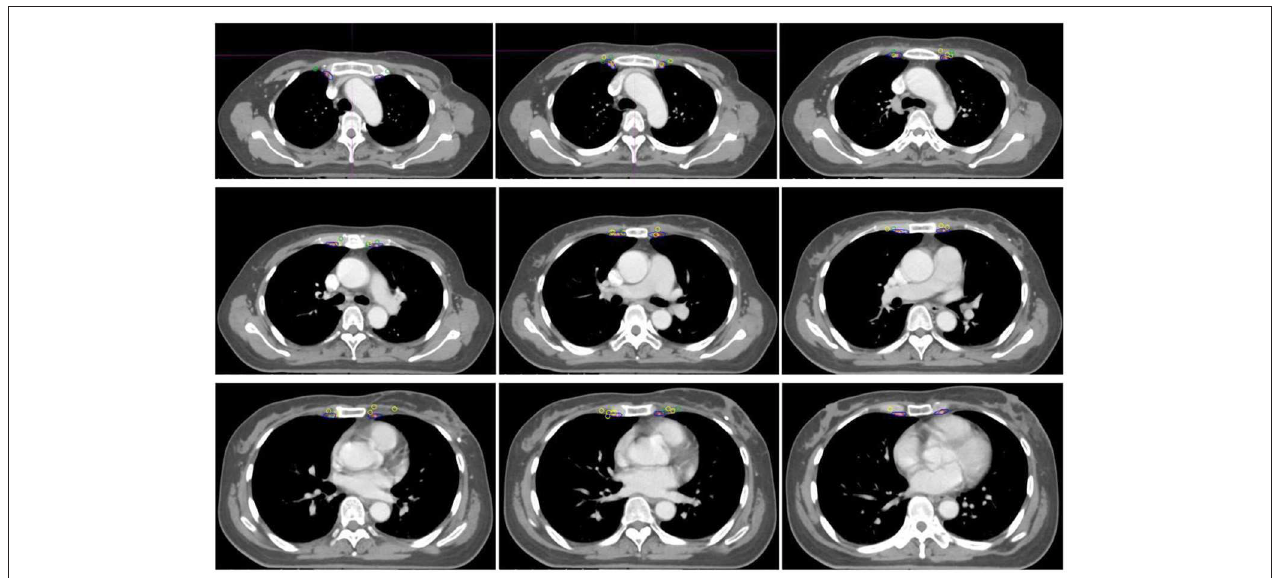
FIGURE 2 | The position relationship between CTV RTOG , CTV DBCG , and IM-SLNs. Red, blue, dark green, and yellow circles indicate the CTV RTOG , CTV DBCG , solitary IMNs, and multiple IMNs, respectively.